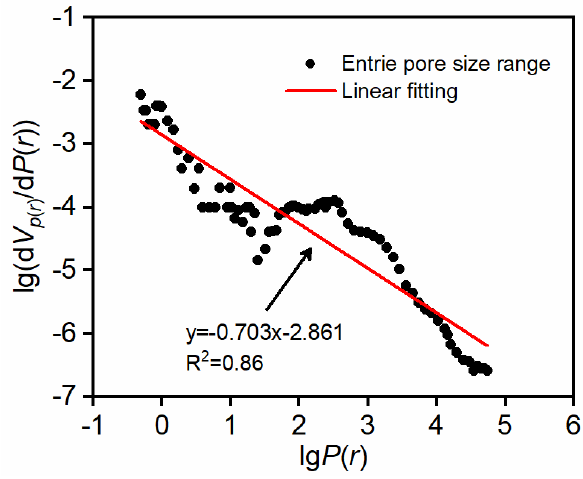
Figure 1: Logarithm plot of lg(d V P ( r ) /d P ( r ) ) and lg P ( r ) in the entire pore size range (Sample